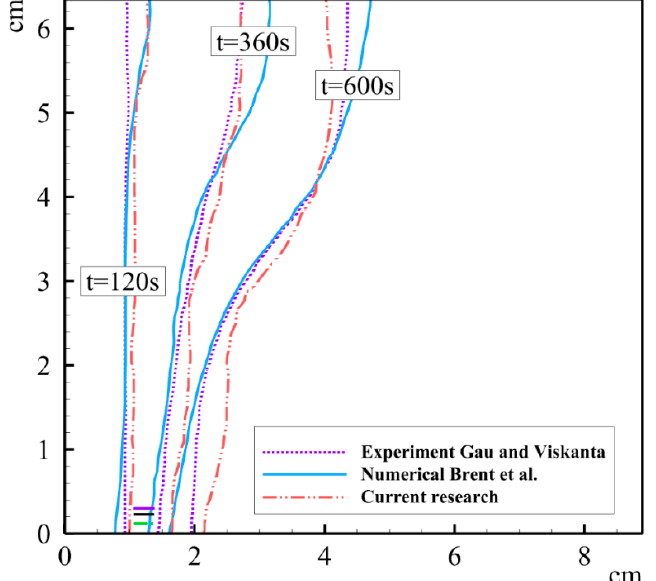
Figure 4. The melting interface simulated in the current study and [62] against the experiment of [61] .